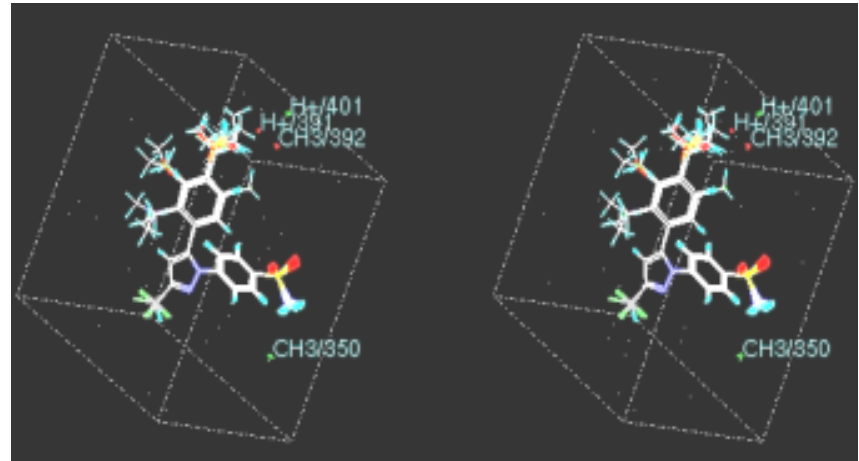
Figure 4. Stereoview of the molecular rectangular field grid around the superposed molecular units. Both steric (CH ) and electrostatic (H + ) grid points in the final QSAR equation are labelled. 3 RSA